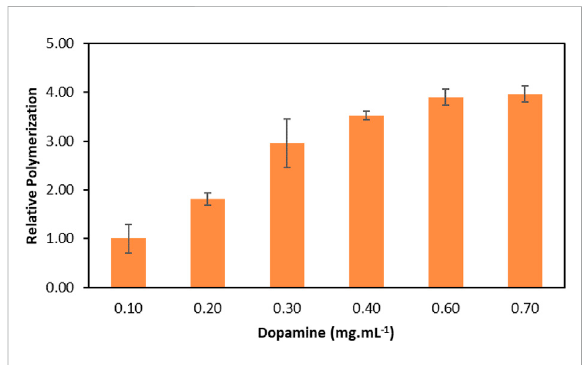
FIGURE 4 Effect of dopamine concentration in the relative enzymatic dopamine polymerization in relation to the conventional reaction (without laccase) in PPG 400 + K 2 HPO 4 ABS after 1 h reaction at 30 °